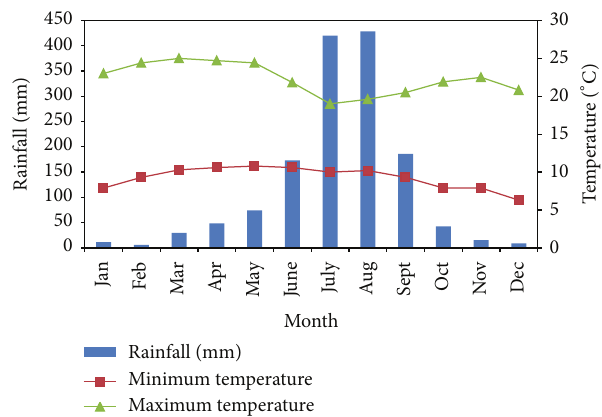
Figure 2: Mean monthly rainfall and mean monthly maximum and minimum temperatures of the study